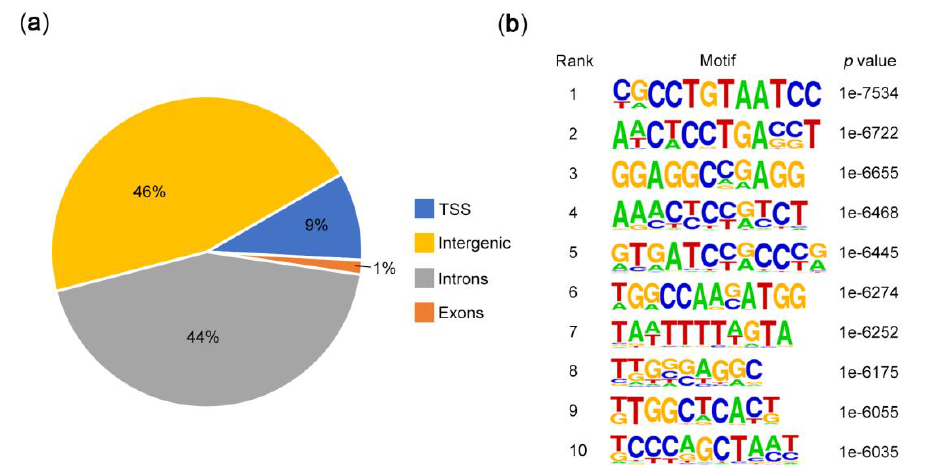
Figure 1. Peak and motif analysis of ChIP-seq. ( a ) A pie chart of peak distribution on gene elements. ( b ) Motif scan analysis of significantly enriched DNA-binding regions not collected in the Homer database.